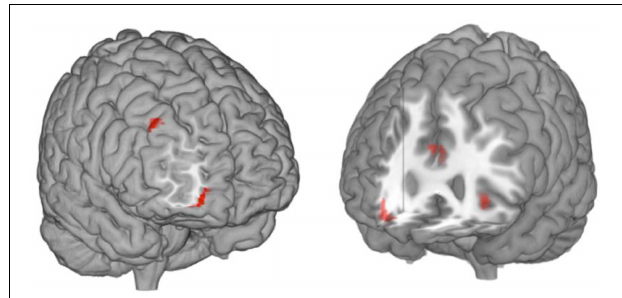
FIGURE 2 | Activation map for self-chosen versus introjected goals. (Left) Right MPFC (frontal pole) and dorsolateral PFC response to goals correctly classified as self-chosen. (Right) Response of right MPFC, left MPFC, and ACC to